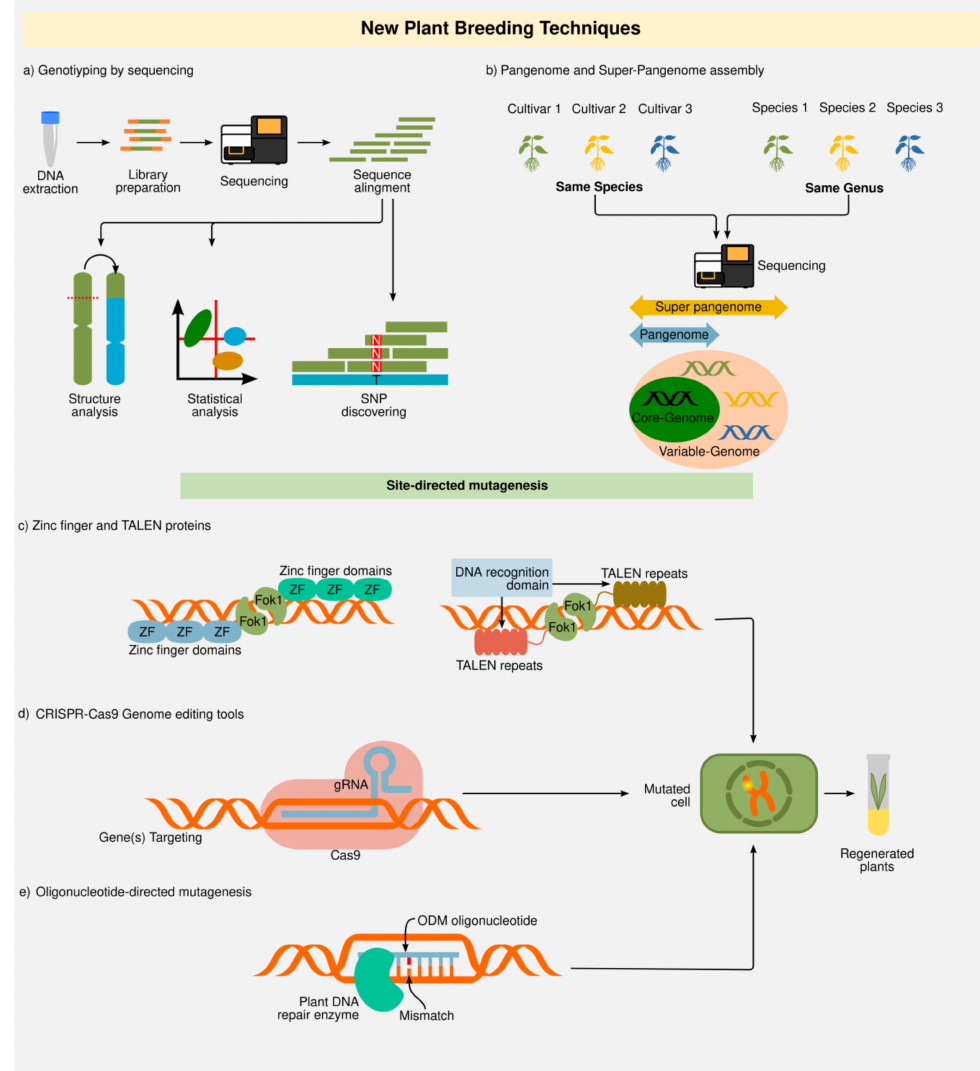
Figure 3. New plant breeding techniques. ( a ) Genotyping by sequencing. This method allows simultaneous analysis of large numbers of DNA samples using restriction enzymes to decrease genome complexity and generate thousads of SNP-like markers (one-base polymorphisms) using sequencing platforms. ( b ) Pangenome and super pangenome assembly. Describes the collection of all genes in a species (pangenome) or genus (super pangenome). These have a nucleus genome that has all the genes shared by a species and the variable genome that only some individuals have. ( c ) Zinc finger and TALEN site direct mutagenesis. Zinc finger nucleases are constituted by the fusion of